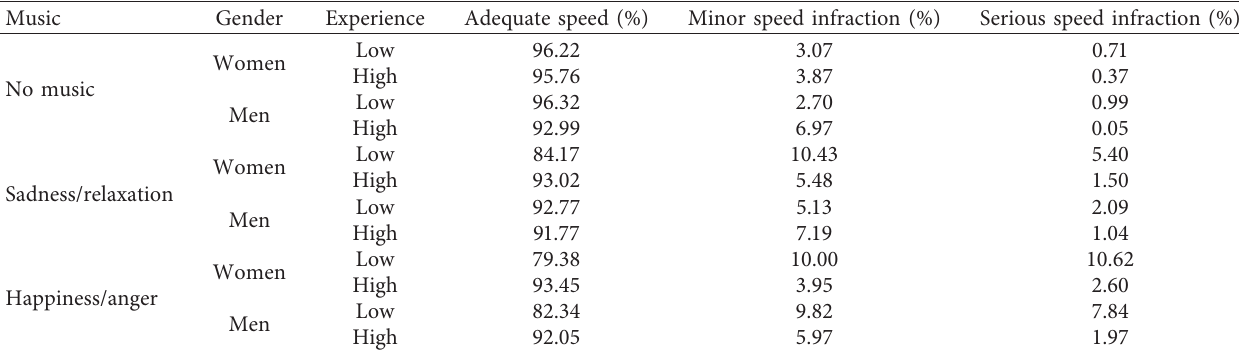
Table 9: Probability of speed violation based on music, gender, and experience at the wheel.